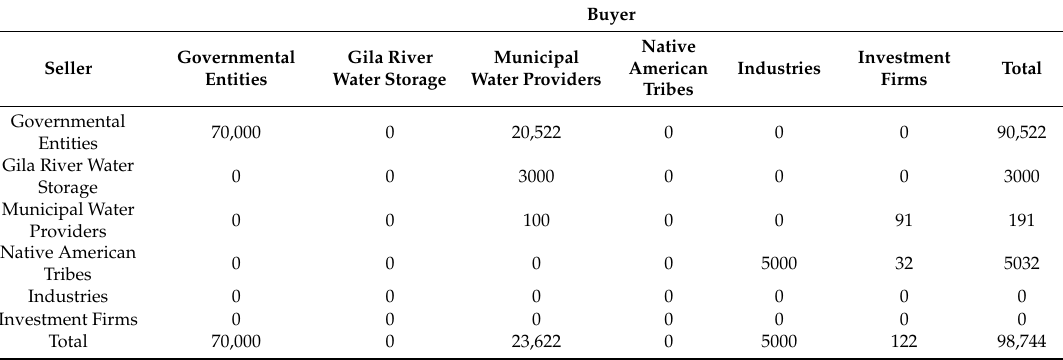
Table 5. Volume of Arizona long-term storage credit transactions in the Pinal AMA, from seller to buyer, from 1994 to